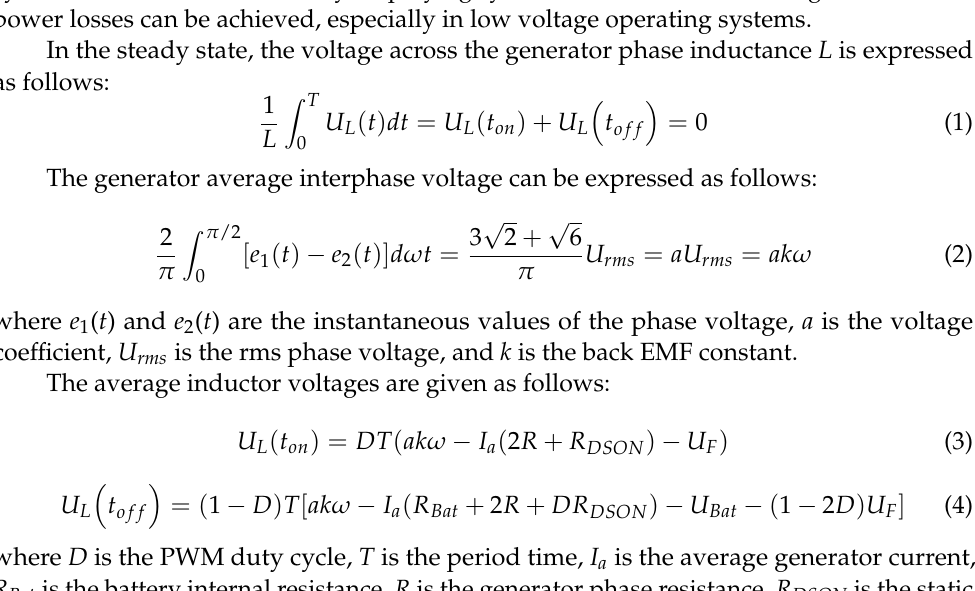
Figure 3. Two-switch converter operating states in the first sector 0– π /2: ( a ) two-phase dynamic braking and ( b ) energy recovery to the battery.